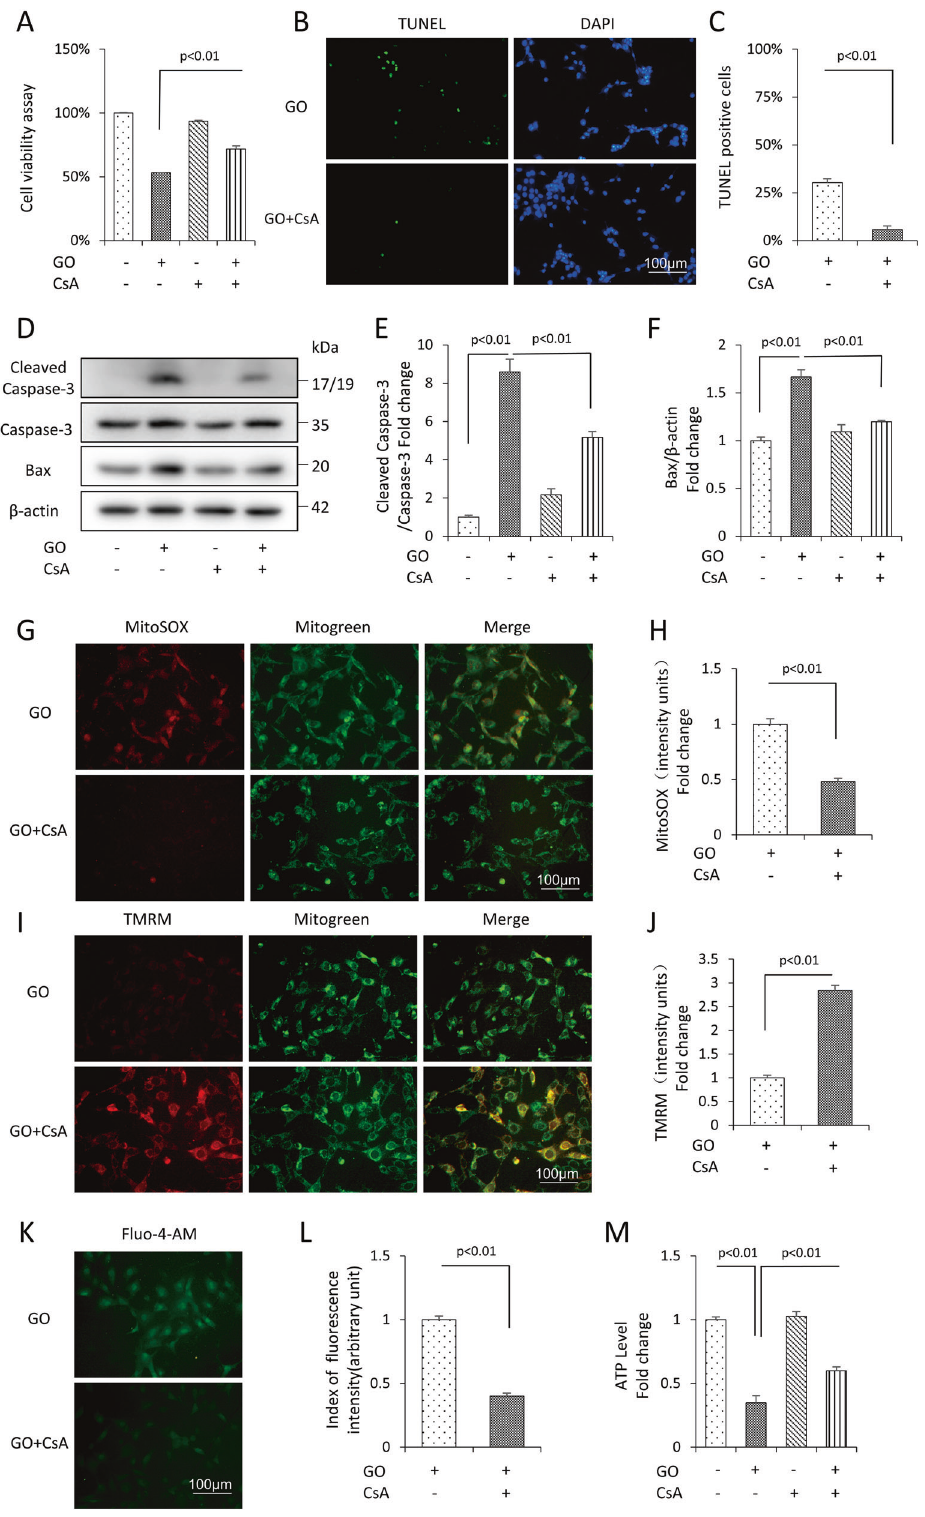
Fig. 3 Inhibition of mPTP by CsA reversed glucose oxidase-induced apoptosis and mitochondrial oxidative damage in mDPC6T cells. A Cell viability determined by CCK8 assay in the presence of glucose oxidase with or without CsA. B , C TUNEL staining and assay. D – F Protein level of cleaved Caspase-3, Bax by Western blot and quanti fi cation analysis. MitoSOX staining ( G ) and quanti fi cation ( H ) in the indicated groups. TMRM staining ( I ) and quanti fi cation ( J ) in the indicated groups. Fluo-4-AM staining ( K ) and quanti fi cation ( L ) in the indicated groups. M ATP in the indicated groups. The values are expressed as the means ± SD ( n =